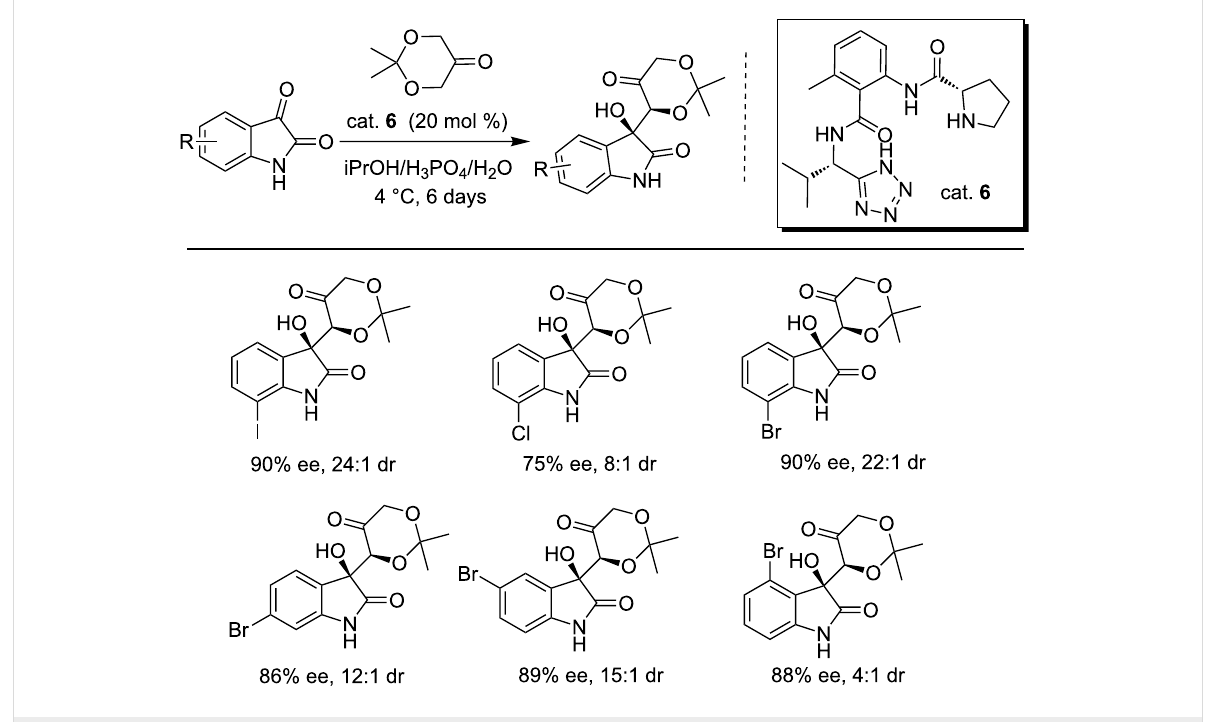
Scheme 19: Enantioselective aldol reaction of isatins and 2,2-dimethyl-1,3-dioxan-5-one.